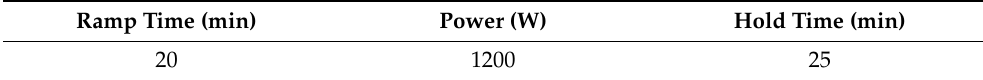
Table 2. Digestion method for the